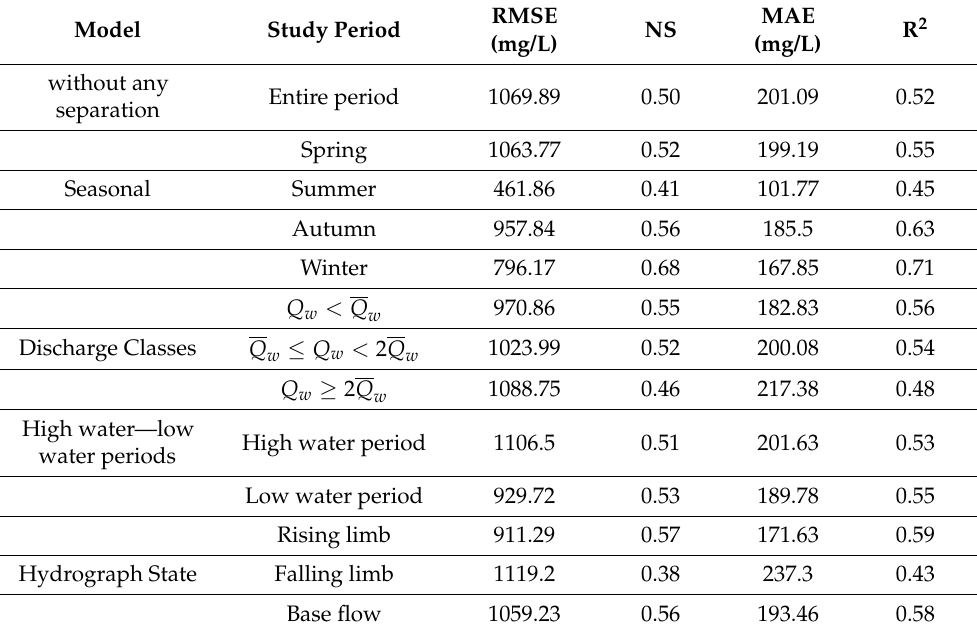
Table 8. Evaluation of SVR models during the testing